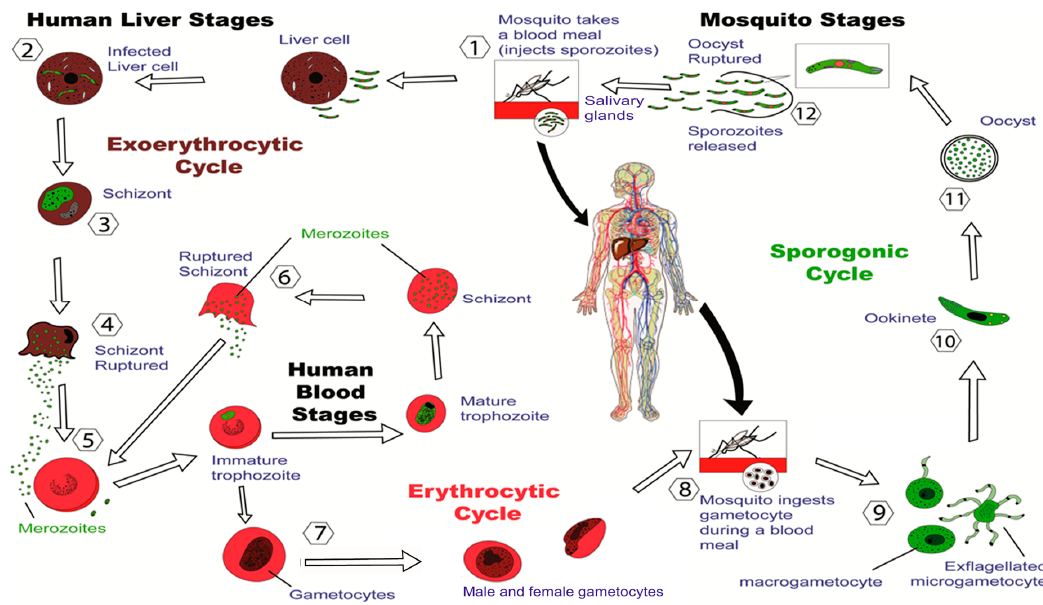
Figure 1. Life cycle of Plasmodium malaria parasites. Malaria parasites have a complex, multi-staged life cycle that occurs in two living beings: the vector mosquitoes and vertebrate hosts. (1) Plasmodium parasites enter the blood of their vertebrate host when an infected female Anopheles mosquito bites a person and injects the parasites in the form of sporozoites. (2) The sporozoites enter into the bloodstream and head immediately for the liver, where they invade liver cells. (3–4) The parasites reproduce in the liver to produce thousands of haploid forms, called merozoites. (5) The merozoites emerge from the liver and re-enter the bloodstream, where they infect red blood cells (RBCs). (6) They continue to reproduce asexually in the RBCs and release newly formed merozoites back into the bloodstream. Thousands of parasite-infected cells in the host’s bloodstream can lead to symptoms, such as recurrent fever, chills, headache, anemia, fatigue, perspiration, anorexia, and vomiting. (7) Some merozoites develop into male and female gametocytes, which are the sexual forms of the parasite. (8–9) When a mosquito has a blood meal from an infected person, these gametocytes are ingested in the gut of the mosquito. (10) Male and female gametes fuse together to form a diploid zygote, which develops into ookinetes that burrow in the midgut wall of the mosquito to form oocysts. (11–12) After a few days, oocysts burst and release sporozoites into the body cavity of the mosquito. These sporozoites then invade the salivary glands of the mosquito. The cycle continues when the mosquito bites an appropriate host, injecting the sporozoites into the animal’s bloodstream [26–28].